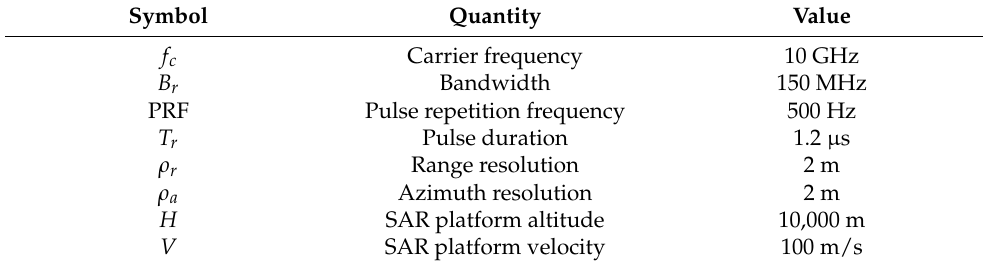
Table 1. Parameters of